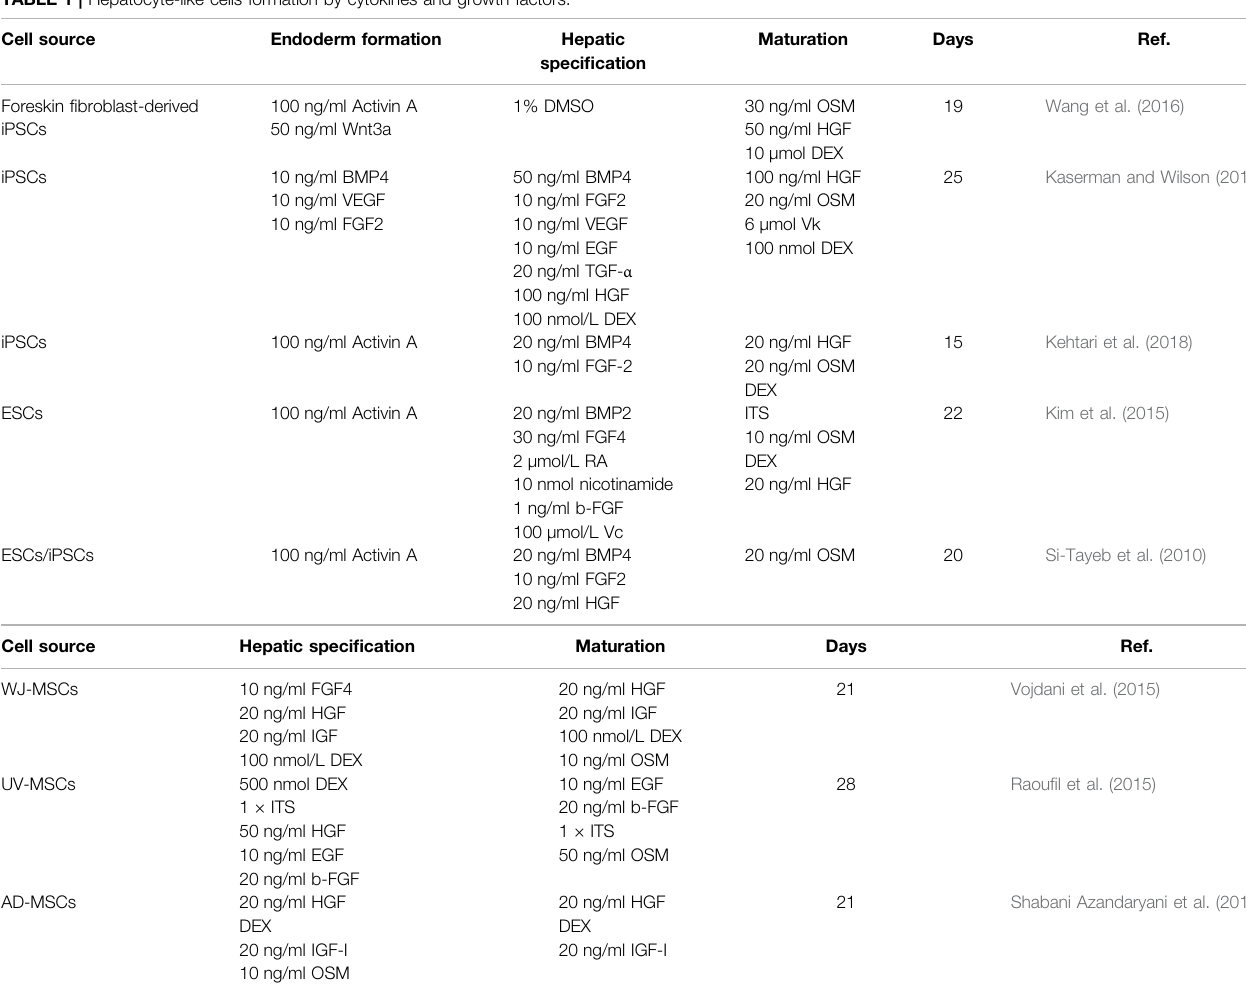
TABLE 1 | Hepatocyte-like cells formation by cytokines and growth factors.